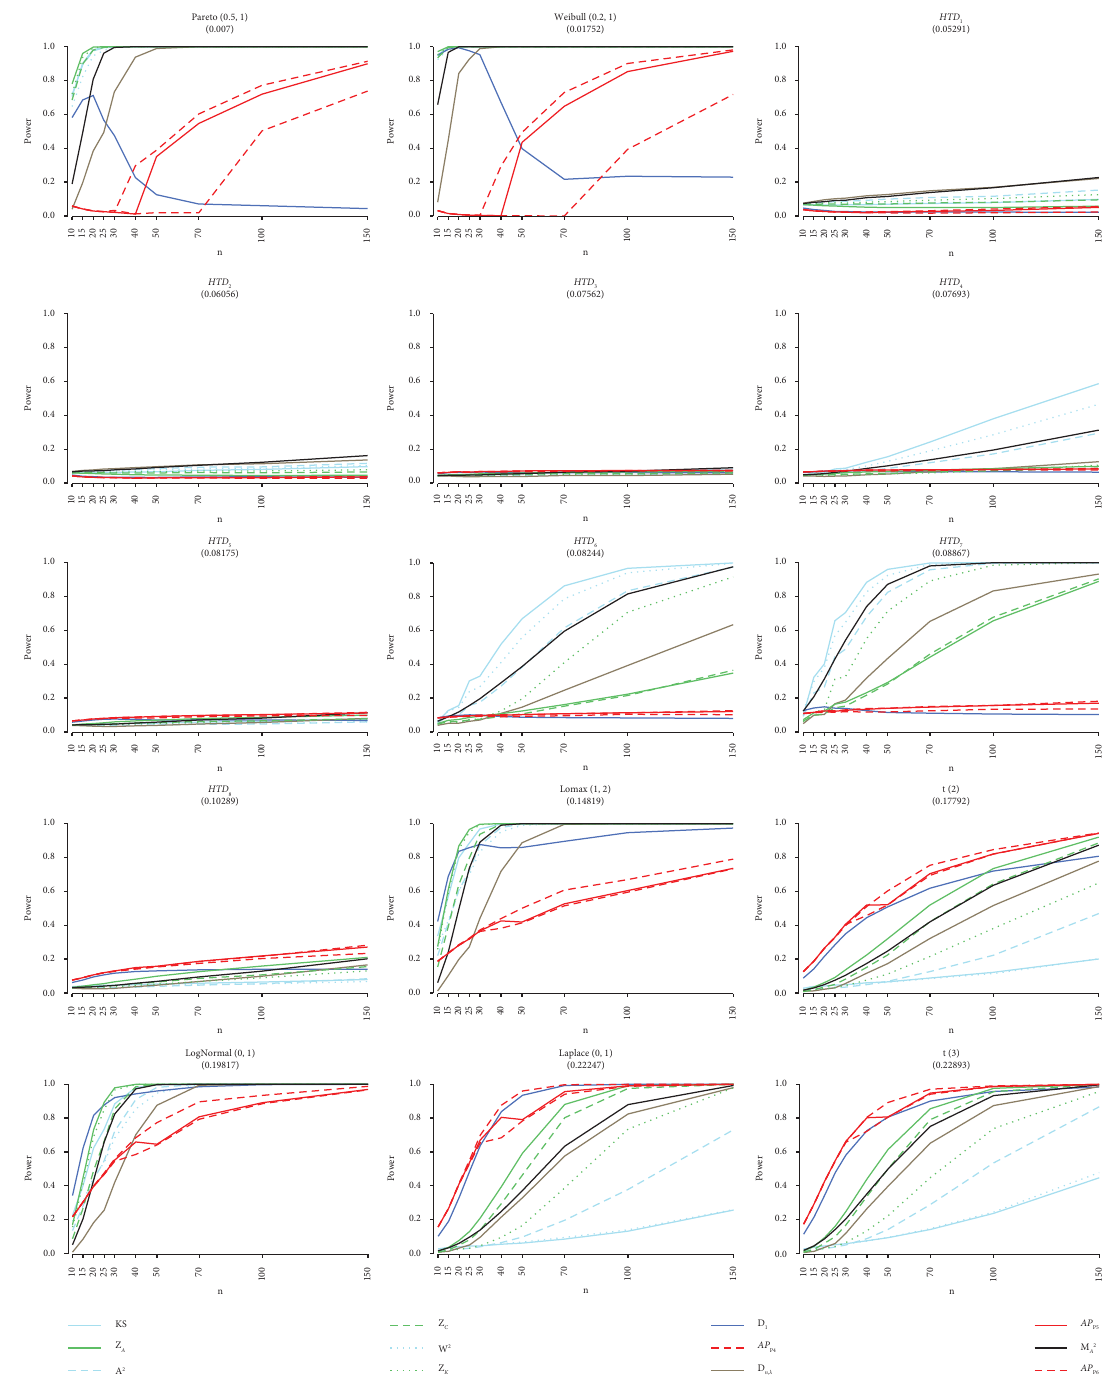
Figure 2: Te empirical powers for diferent alternative distributions